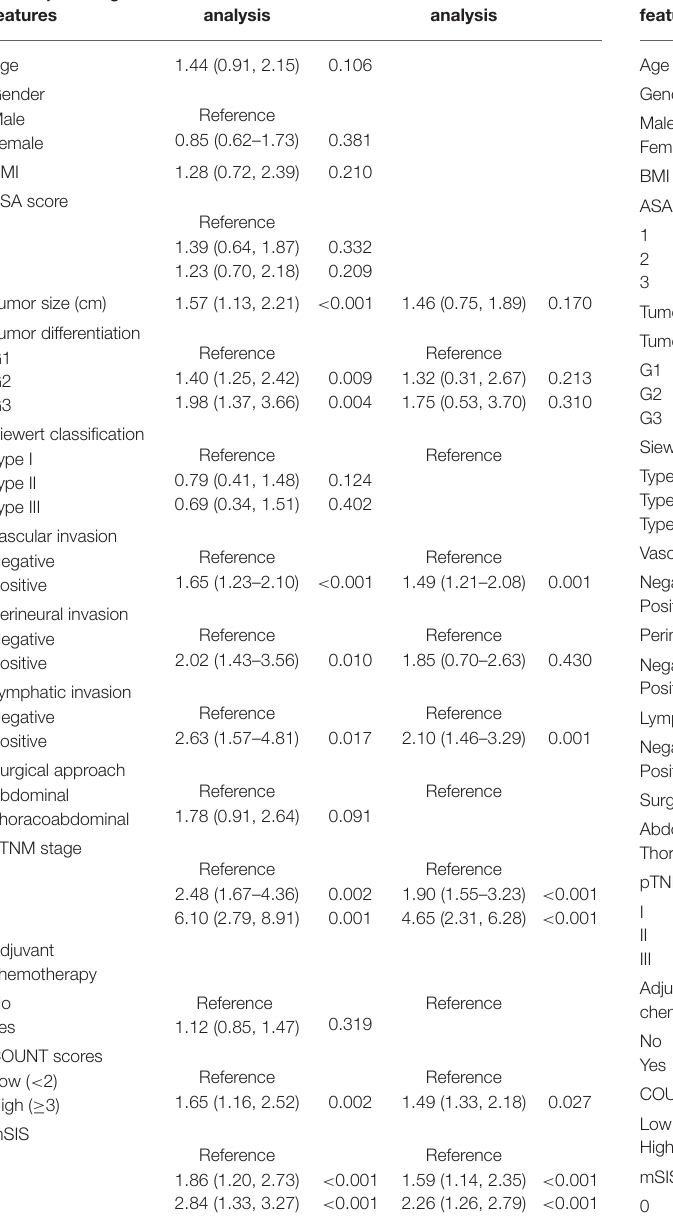
TABLE 2 | Univariate and multivariate analysis of clinicopathologic variables in relation to OS in patients with AEJ. Clinicopathological features